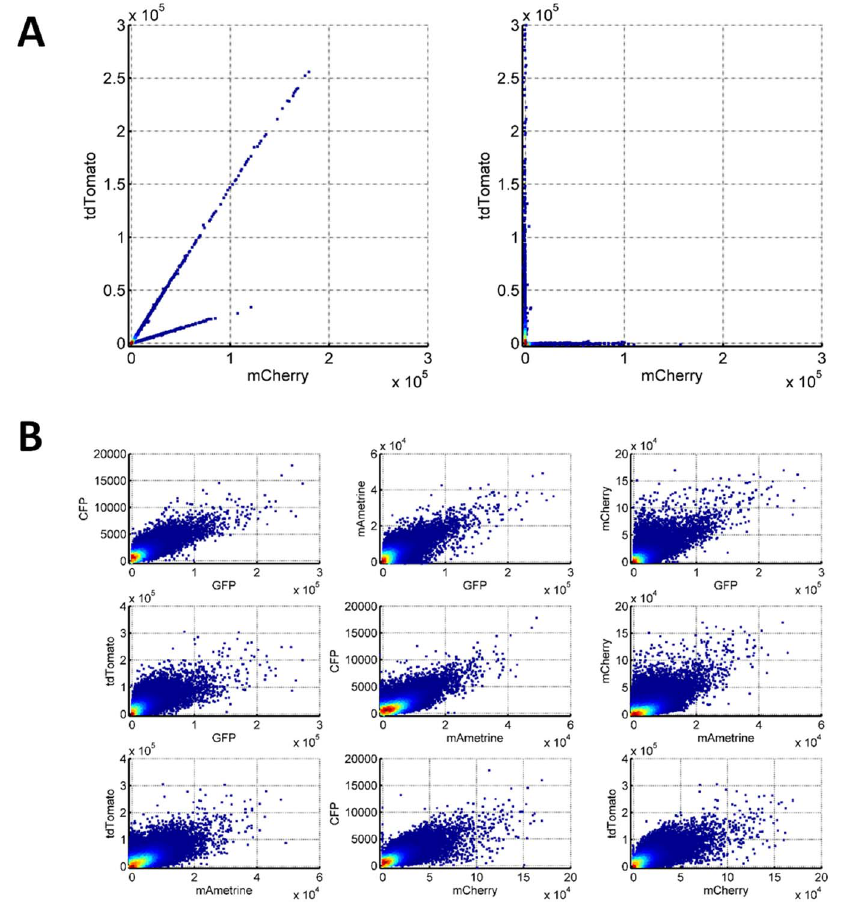
Fig. 6. Spectral unmixing and verification of multiple transgenes in single ES cell clone. (A) Example of linear unmixing for cell lines with single mCherry and tdTomato fluorescence protein. (B) Linear unmixing of multiple fluorescence proteins based on ES cell lines with different individual fluorescence